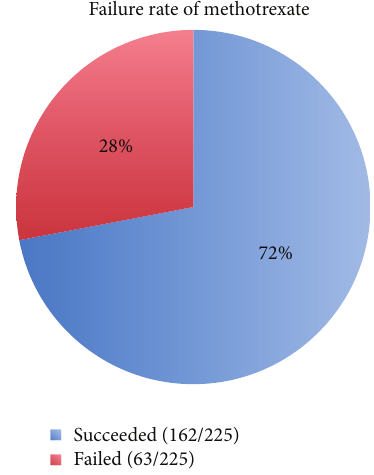
Figure 1: Failure rate of the 1st dose of